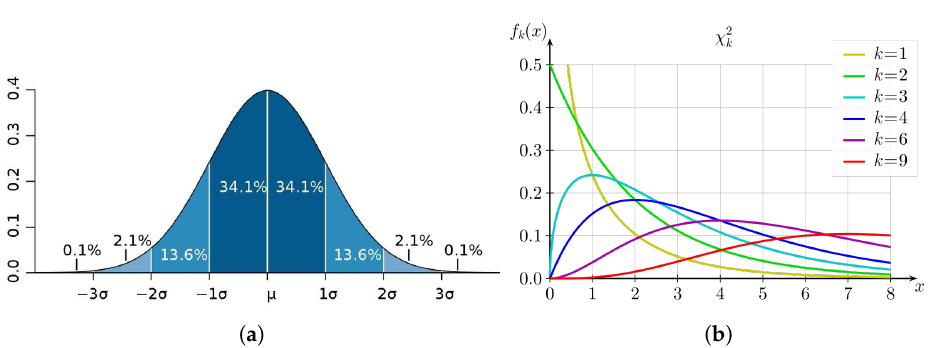
Figure A8. ( a ) Probability density function for the Gaussian distribution. Adapted from: [106]. ( b ) Probability density function for the chi-square distribution. Adapted from: